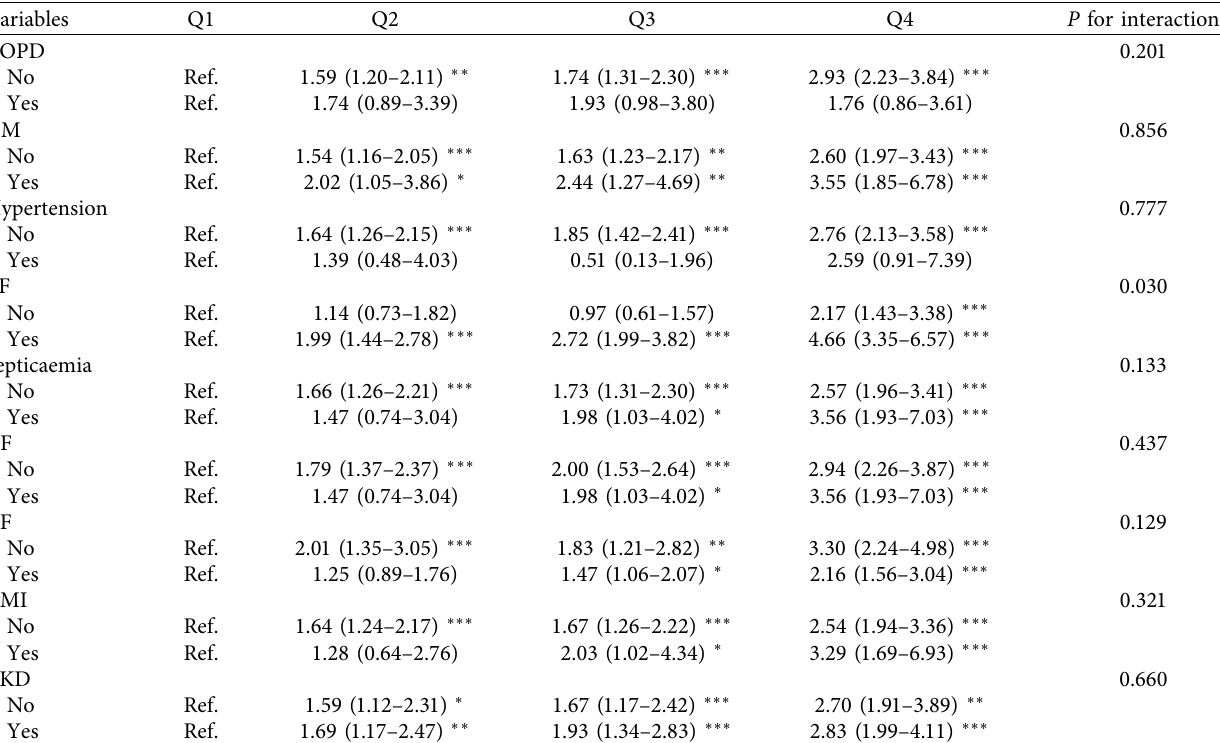
Table 3: Subgroup analysis for the levels of lactic acid predicting in-hospital mortality.